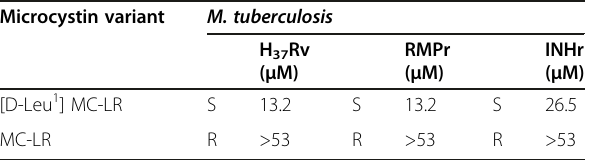
Table 2 Minimum inhibitory concentration (MIC) of the microcystin variant [D-Leu 1 ] MC-LR from extracts of M. aeruginosa RST 9501 and MC-LR (commercially available) against M. tuberculosis strains Microcystin variant